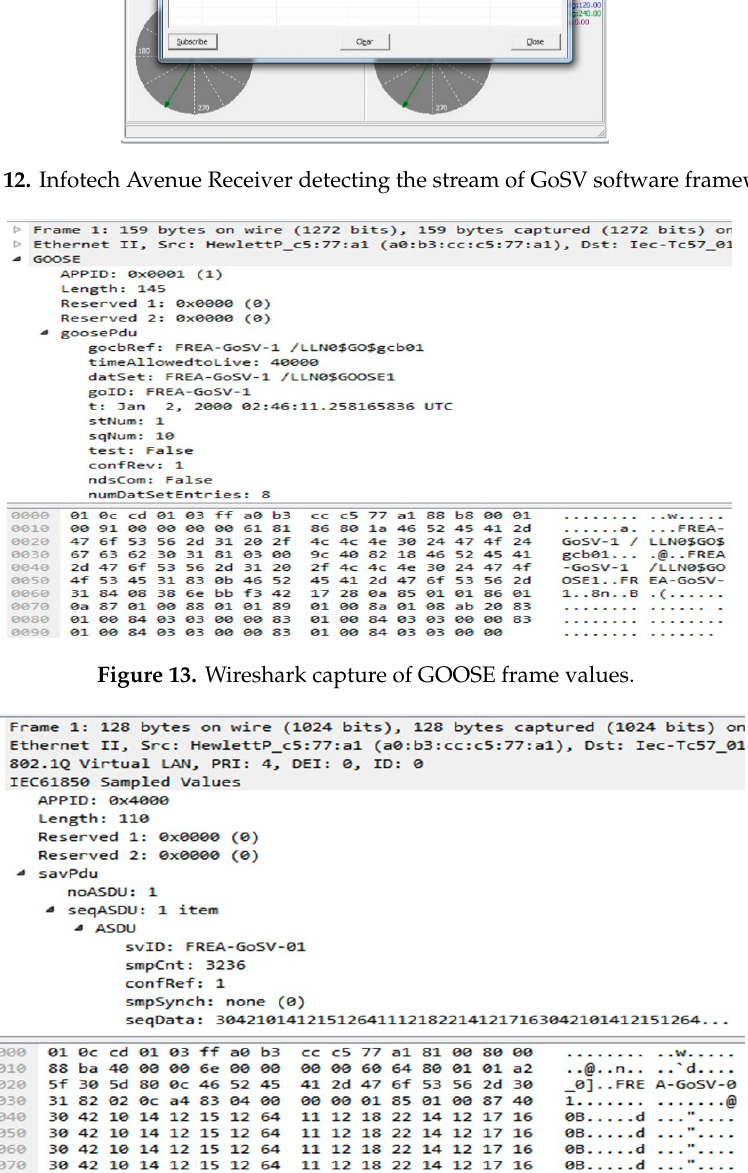
Figure 14. Wireshark capture of SV frame values.